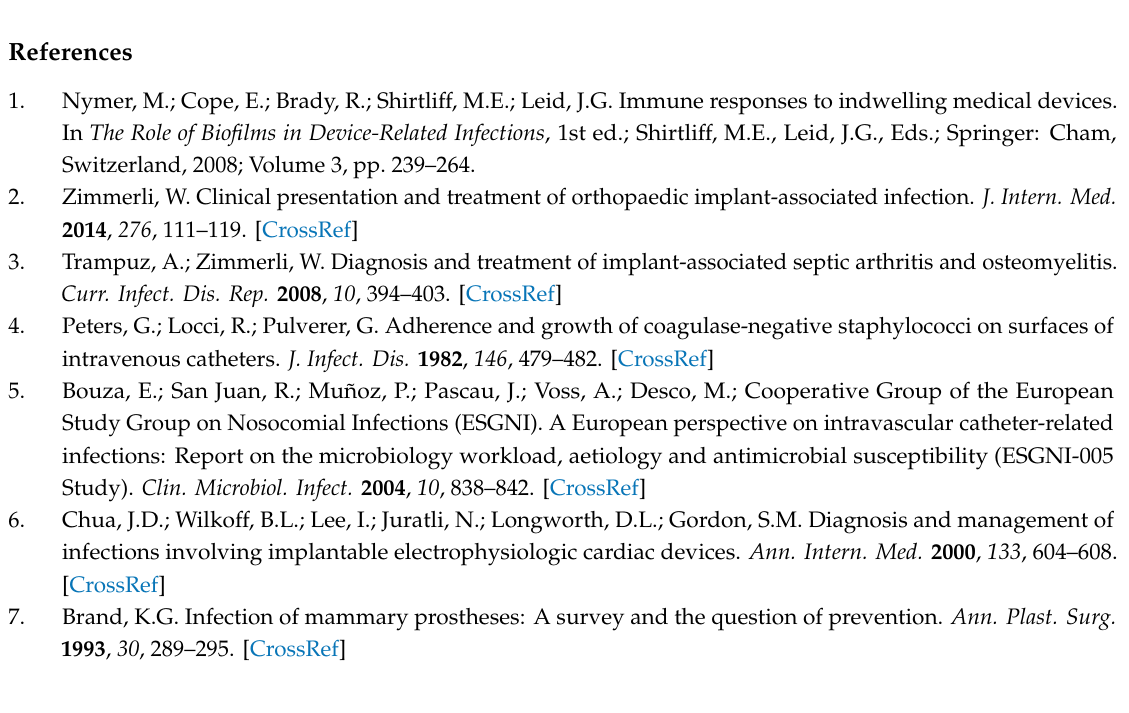
Figure S1: The viability of S. aureus ATCC 25923 biofilm cells treated with trypsin or 100 mM TEAB bu ff er (control). Figure S2: Length-scale dependent roughness of the materials. Figure S3: Venn diagrams indicating the number of proteins specific and common to the indicated materials at di ff erent time points of growth. Table S1: The MaxQuant output-file showing the identified proteins after searching the MS / MS raw data against the UniProt Staphylococcus protein database. Table S2: The identified matrix-associated surfaceomes from S. aureus ATCC 25923 biofilms formed on di ff erent substrates at indicated time